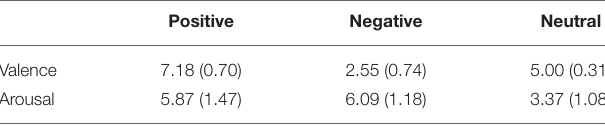
TABLE 1 | Means (standard deviations) of valence scores and arousal scores of the three types of